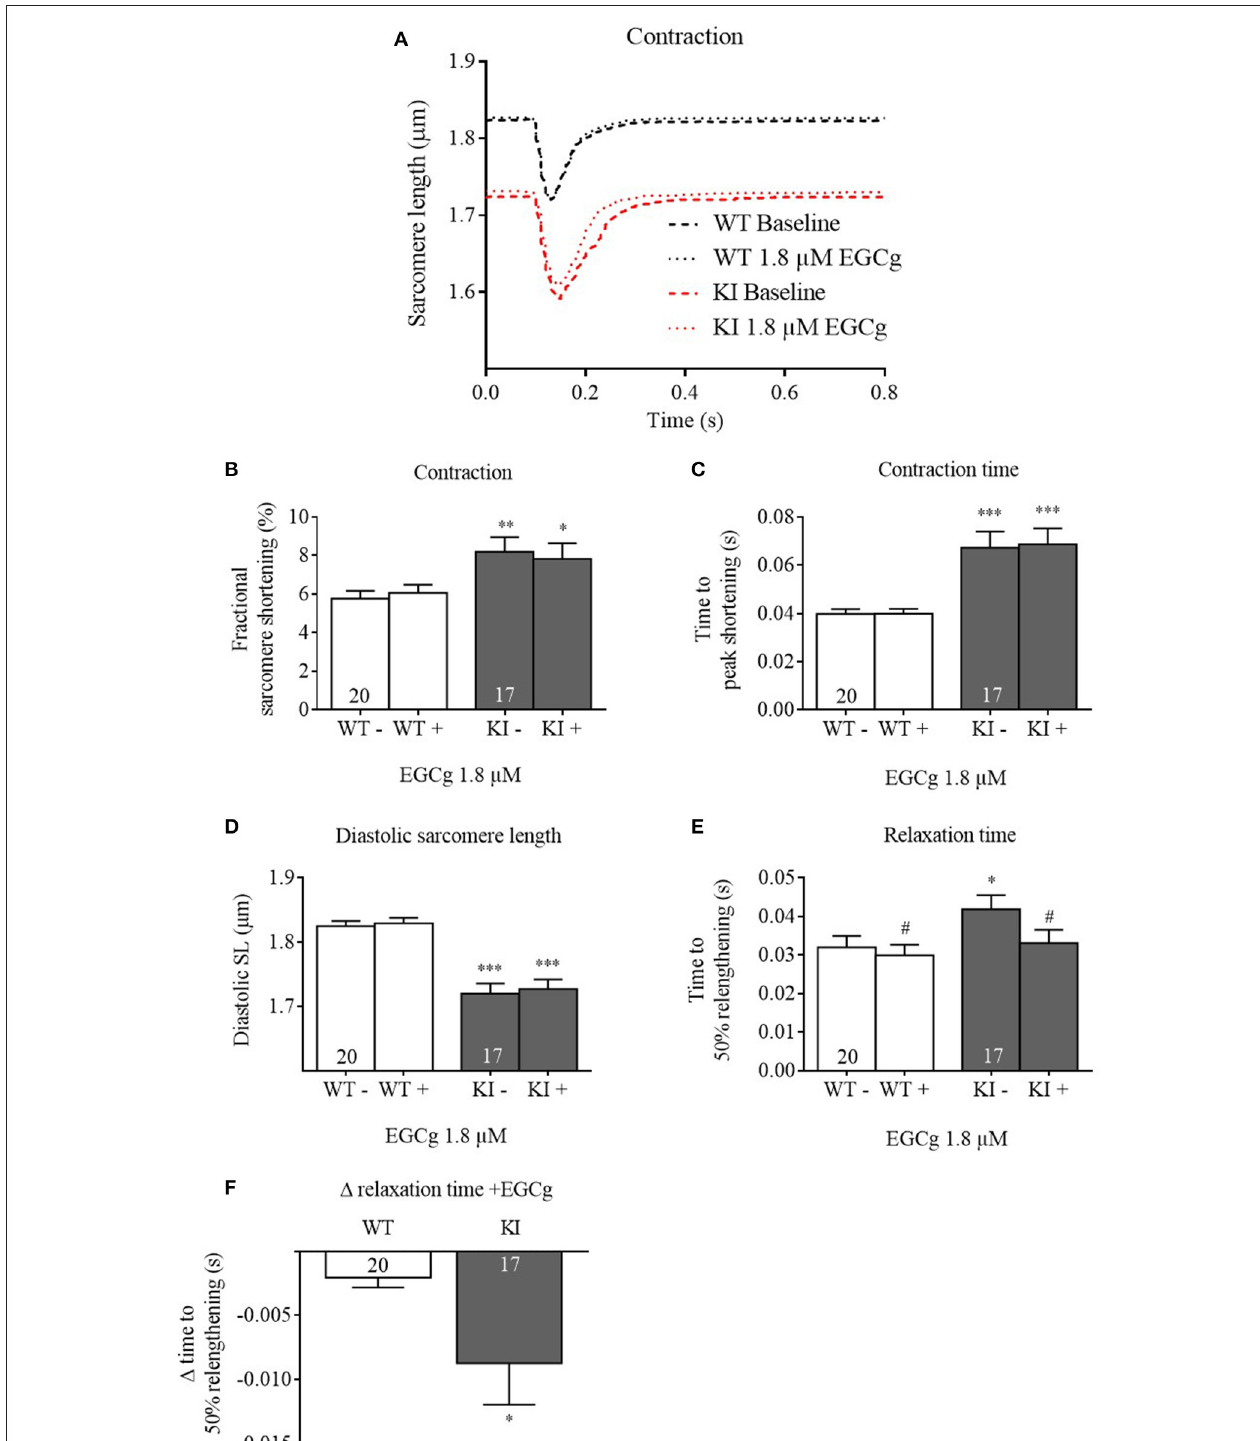
FIGURE 2 | Contractile parameters of Mybpc3 WT and KI cardiomyocytes before and after treatment with EGCg. After isolation of ventricular myocytes from adult Mybpc3 WT and KI mice, paired (before/after EGCg) measurements of contractile function were exerted. (A) Averaged sarcomere shortening traces of Mybpc3 WT (black) and KI (red) cells in baseline and with EGCg. (B) Fractional sarcomere shortening, (C) contraction time (time from stimulation to peak of contraction), (D) diastolic sarcomere length, and (E) relaxation time (time from peak of contraction to 50% relaxation) were analyzed. (F) Delta of relaxation time (before/after EGCg). * P < 0.05, ** P < 0.01 and *** P < 0.001 vs. WT in the same condition, unpaired Student‘s t -test; # P < 0.05 vs. baseline, paired Student‘s t -test, n = 17–22, N = 5.